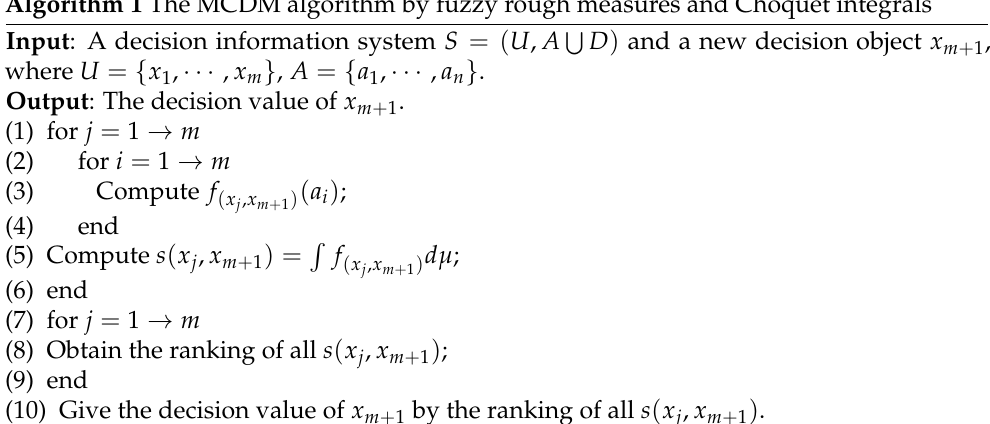
Algorithm 1 The MCDM algorithm by fuzzy rough measures and Choquet